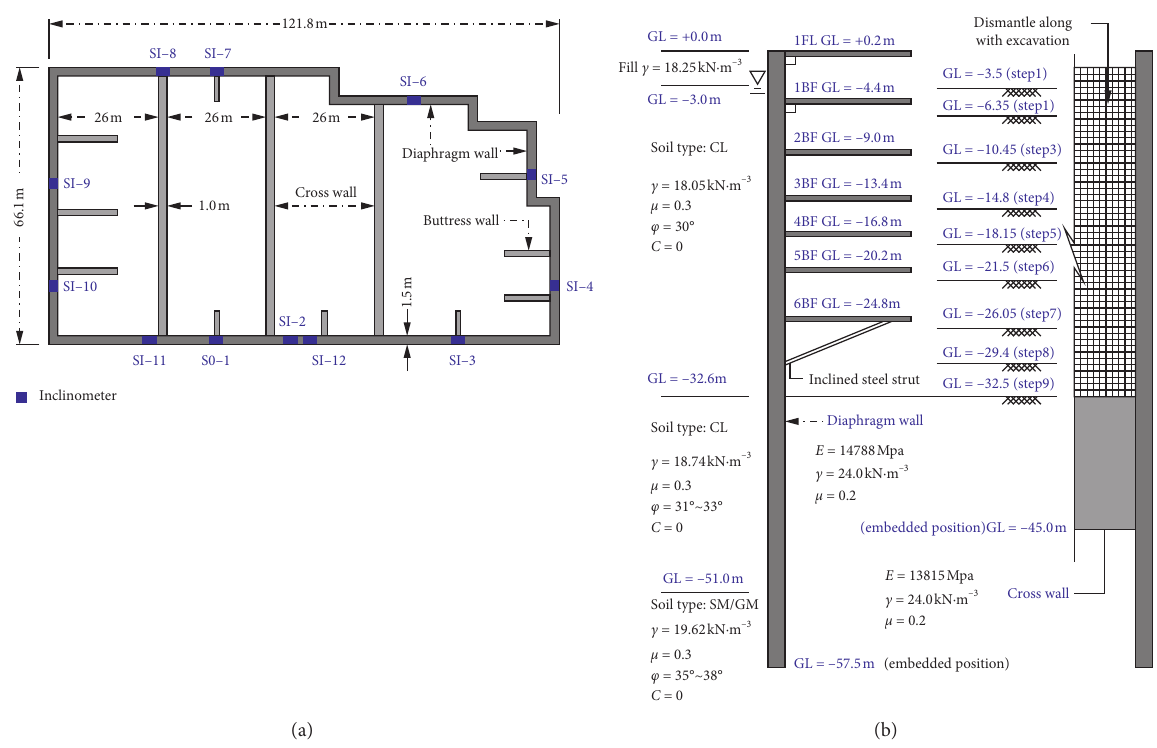
Figure 10: Excavation geometry and stratigraphy. (a) Cross wall geometry and monitoring layout. (b) Excavation and subsurface soil